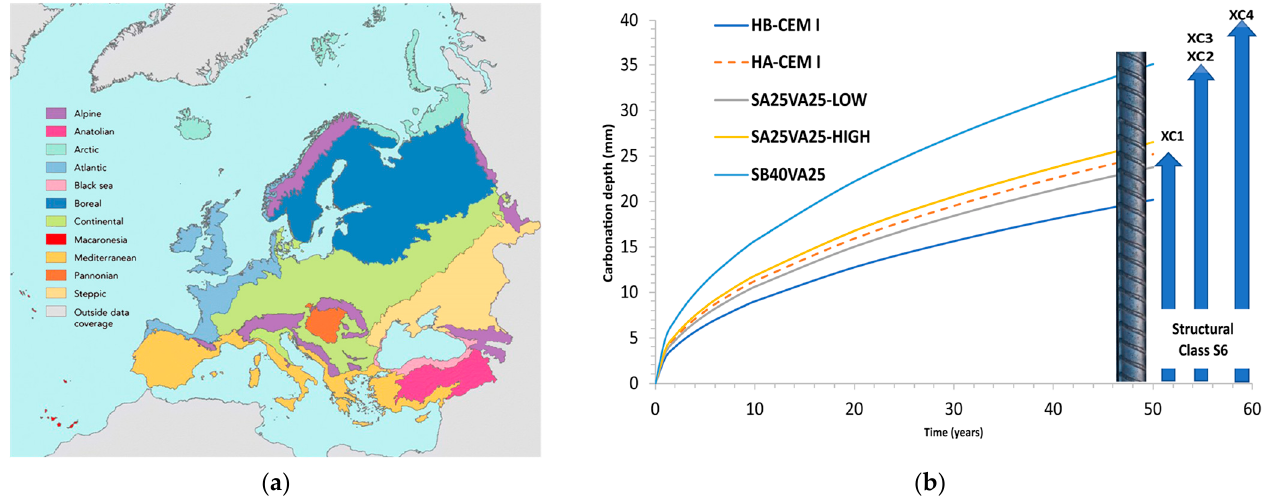
Figure 7. Carbonation-induced reinforcement corrosion estimation: ( a ) biogeographical regions in Europe to consider exposure class (XC1—XC4); ( b ) carbonation depths for ternary cements.